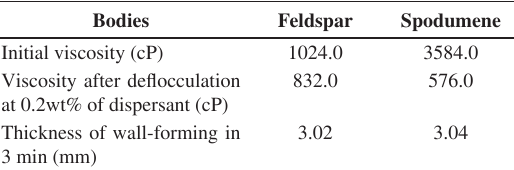
Table 6. Slip properties. Shear rate of 0.7s –1